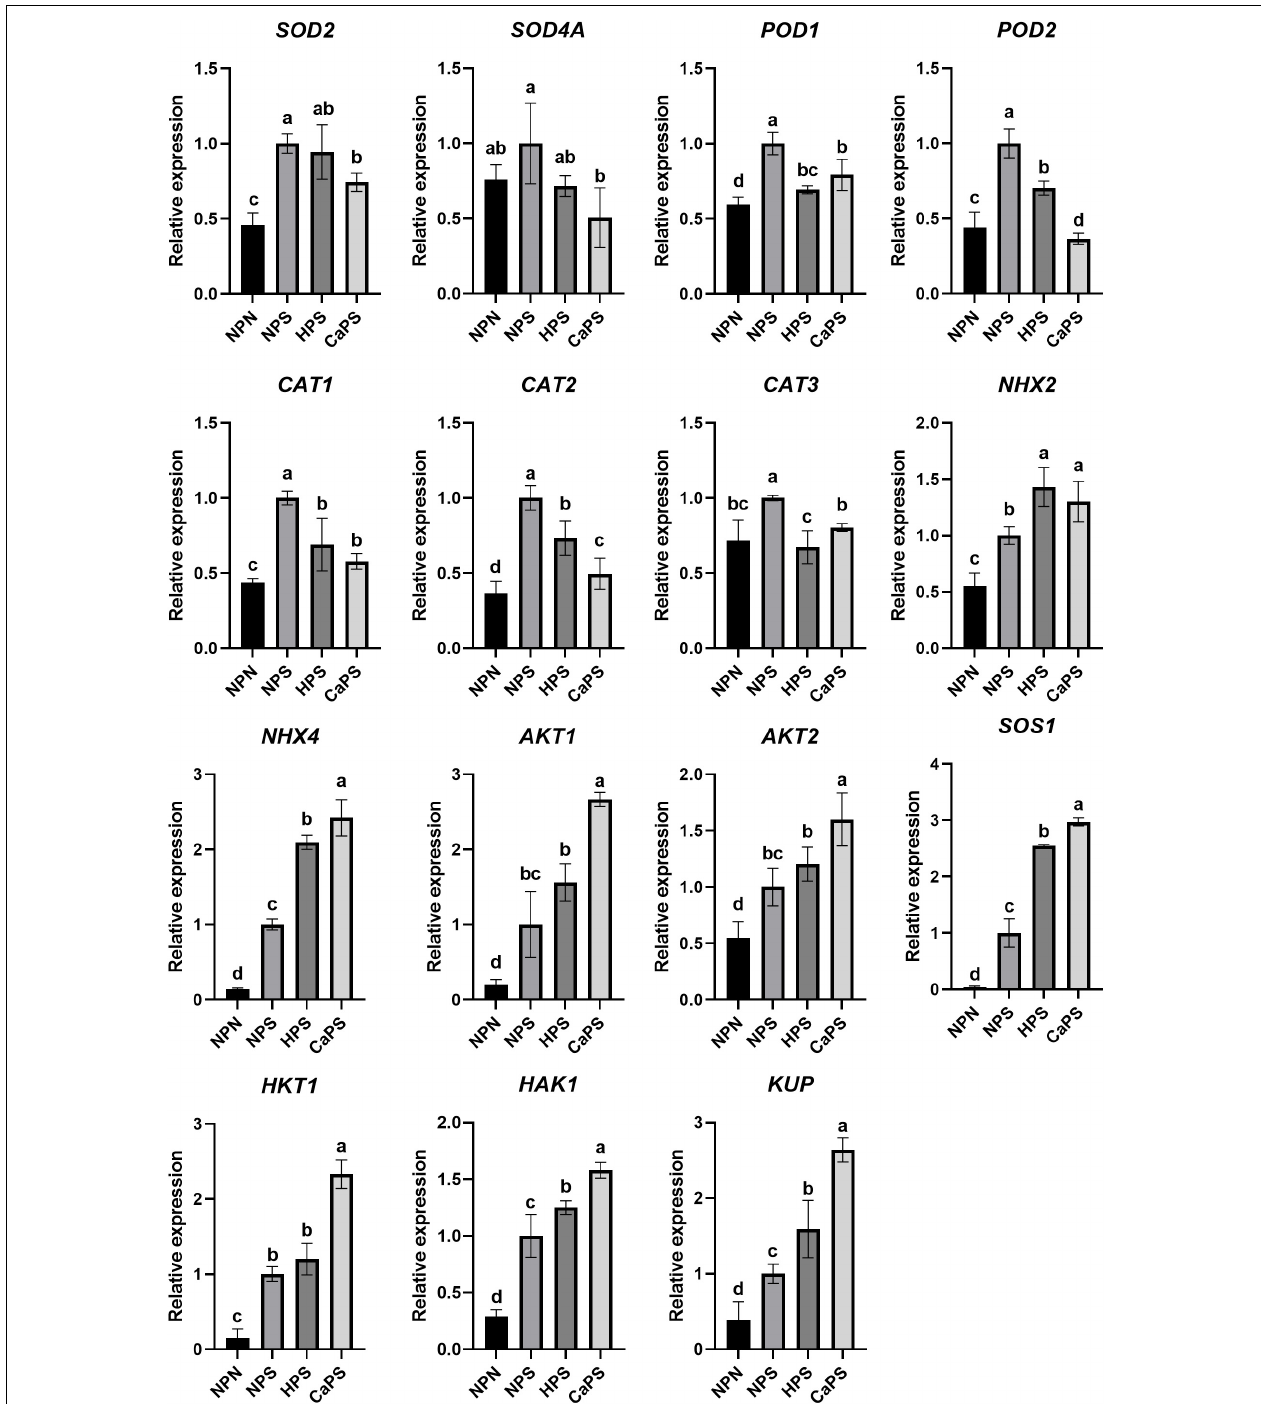
FIGURE 9 | Effects of CaCl 2 priming on the expression of antioxidant enzymes and ion transport genes in sorghum under salt stress.